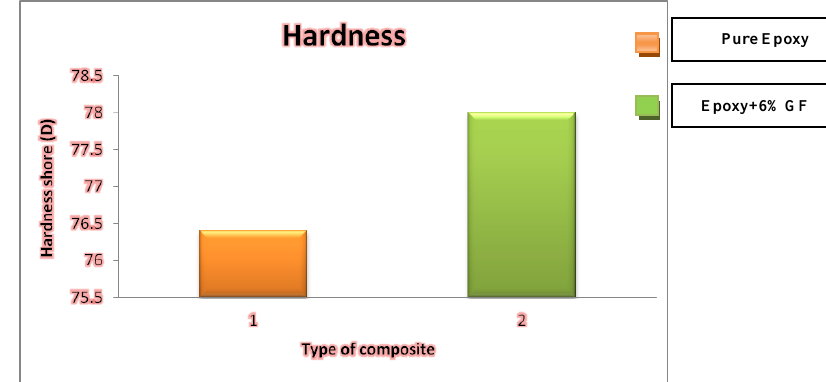
Fig.12: Hardness shore (D) of Epoxy +6% glass fiber composites and pure epoxy .